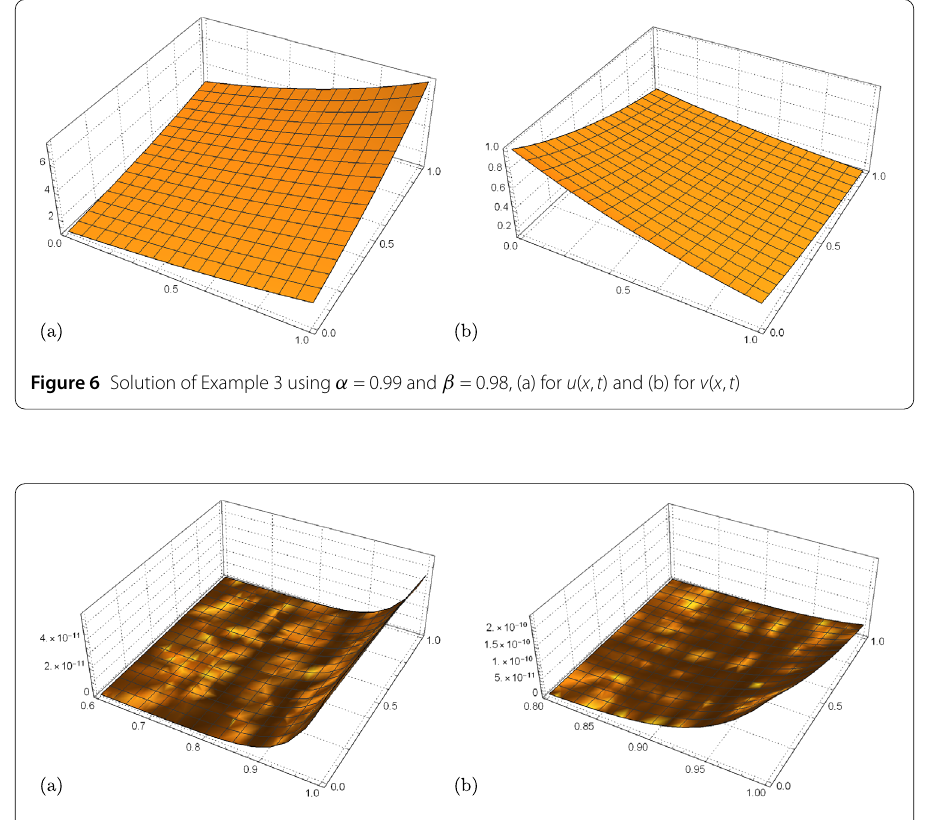
Figure 7 Residual error for (a) u ( x , t ) and (b) v ( x , t ) using 20th order of approximation with α = 0.99 and β = 0.98 for Example 3